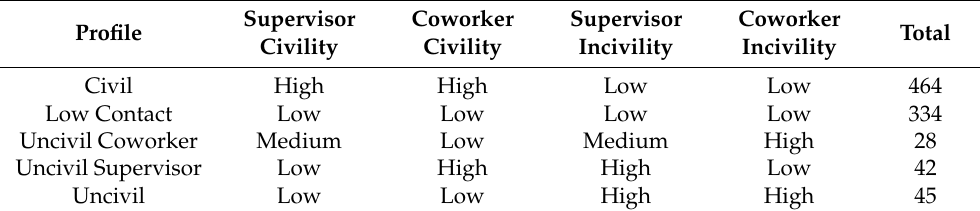
Table 4. Profile patterns.